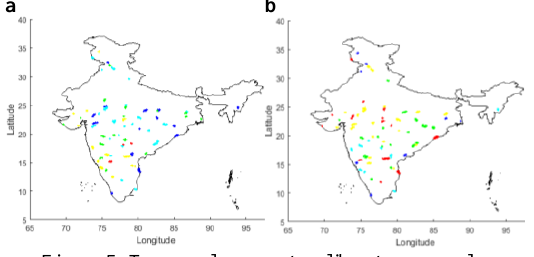
Figure 5: Temporal parameters like storage cycle, maximum peak day are shown for the wetlands. (a) Storage cycle (t s ) of 75 wetlands. Wetlands with t s < 125 days (Red), 125<t s <150 days (Yellow), 150<t s <175 days (Green), 175<t s <200 days (Cyan), 200<t s days (Blue). (b) This figure shows the period during which the wetlands attain maximum peak storage (t 0 ). Wetlands that peak before November are shown in Red, in November as Yellow, December in Green, during January in Cyan and post January peaking wetlands with Blue.